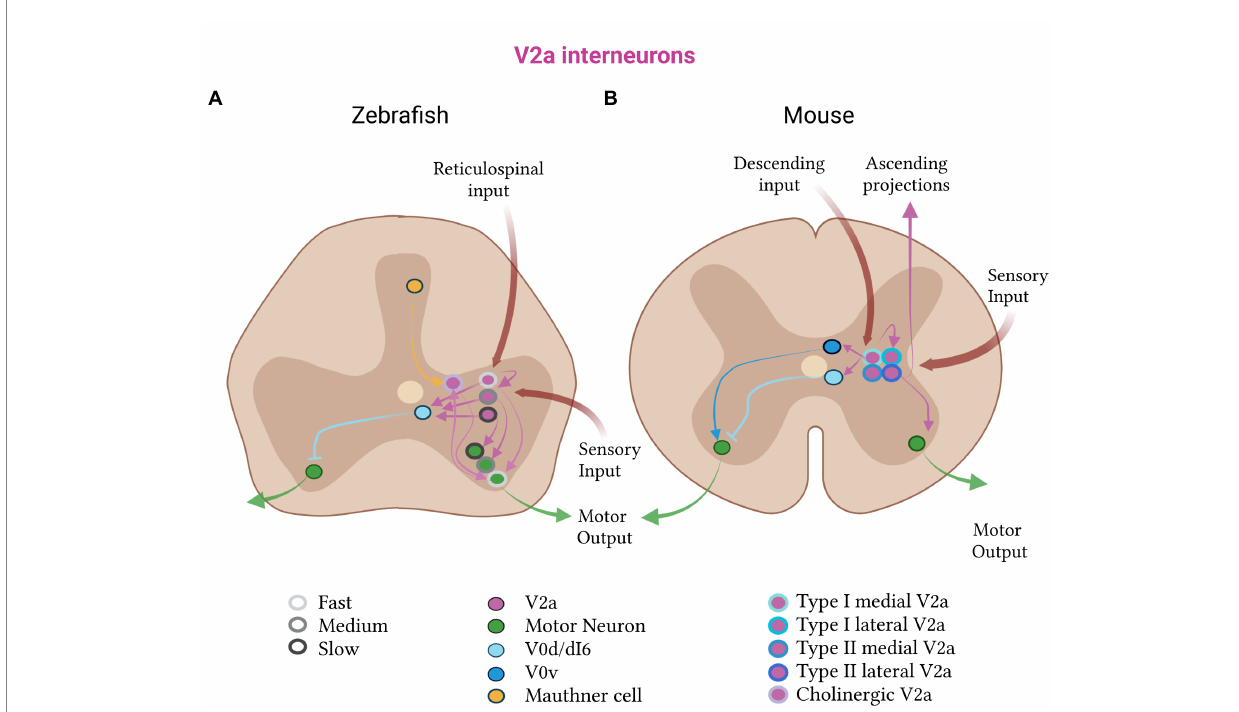
FIGURE 2 Excitatory V2a subtypes in zebrafish and mice. (A) In zebrafish, the V2a class (pink) is divided into fast (light gray, outline), medium (medium gray, outline) and slow (dark gray, outline) subtypes. The fast subtypes are more dorsal than the slow subtypes. Each subtype receives reticulospinal and sensory input, and projects to the corresponding fast, medium or slow class of motor (green) and V0d (light blue) neurons. Zebrafish also have a cholinergic subclass of V2a neurons, which receive input from Mauthner cells and have bidirectional connections to fast motor neurons. (B) In mice, the V2a population receives descending and sensory input, projects to inhibitory V0d and motor neurons, and has recurrent connections. Mouse V2a neurons subdivide into type I and type II, which further divide into medial and lateral subtypes (shades of blue, outlines). Type I V2a neurons connect to V0 neurons (V0d in light blue and V0v in dark blue); type II V2a neurons have ascending